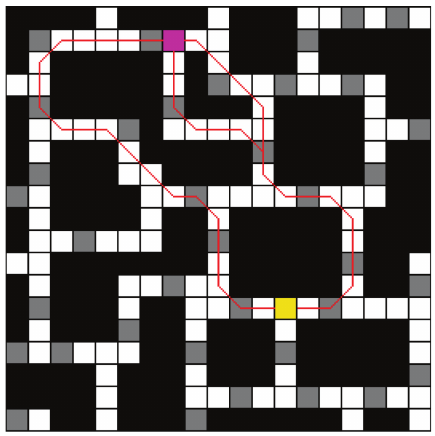
Figure 3: Di ff erent paths generated by probabilistic